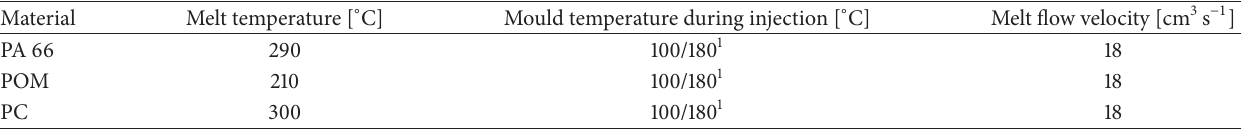
Figure 4: Morphology of the POM tensile bars. Table 3: Processing parameters.